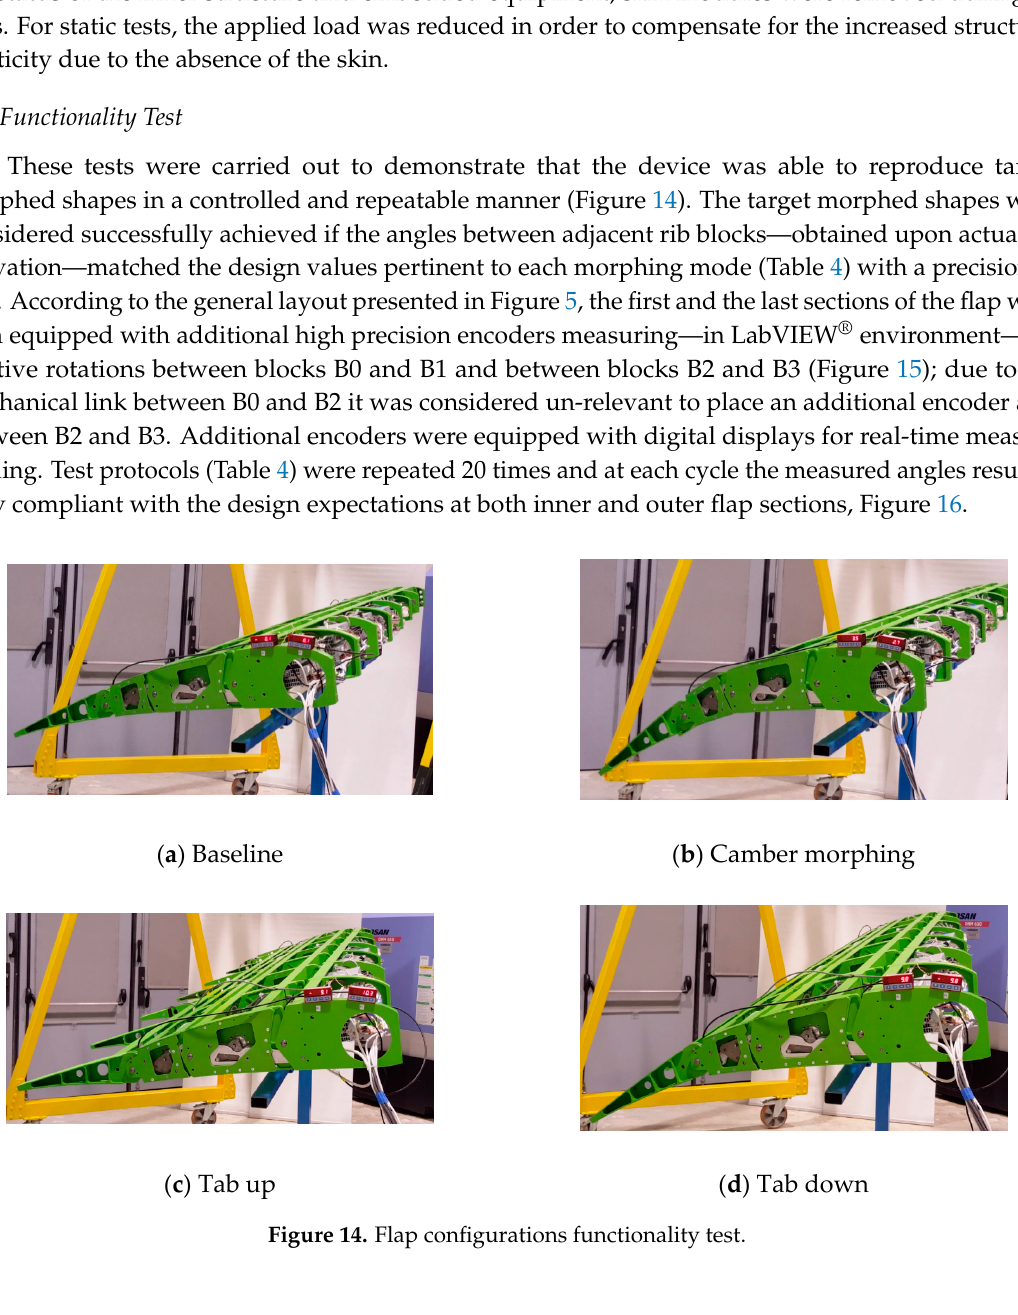
( b ) Figure 15. Sensing strategy: ( a ) hinge encoder ( b ) and rotations displays.